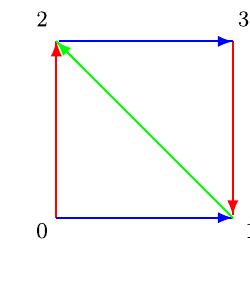
Figure 4: The colored pair of digraphs ( ) H G ,